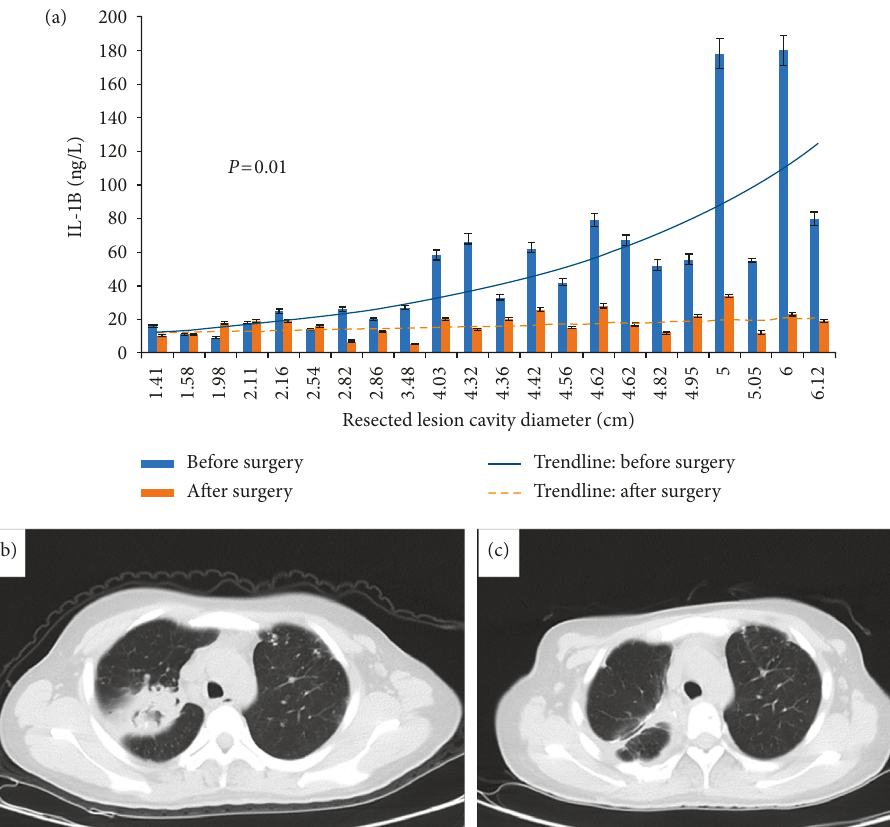
Figure 2: The comparison of IL-1B levels before and after surgery: (a) each dot represents an individual CPA patient. There was a clear upward trend of IL-1B level with the increase of lesion size before the surgery (solid line) and one month later after the surgery; almost all patients’ serum IL-1 decreased (61.3 42.7ng/L vs 23.7 9.4 ng/L, P 0 . 001) (dotted line), especially in patients whose baseline IL-1 levels (cid:31) were over 20ng/L. (b) The CT scan of a 63-year-old male CPA patient with multiple cavities, pleural thickening, aspergilloma, and consolidation in the left upper lobe. His serum IL-1 was 180ng/L prior to the surgery. (c) 3 months later after he received a left upper ± ± lobectomy, no CPA lesions were seen in his chest CT and his serum IL-1 decreased to